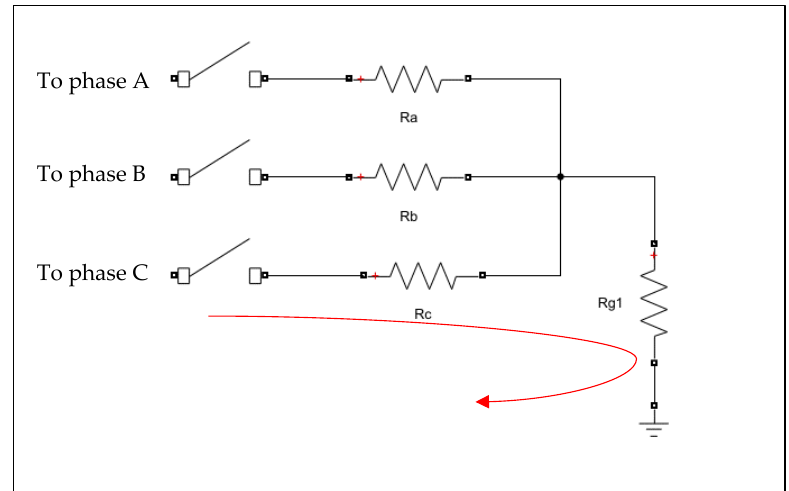
Figure 4. Fault impedance model of insulator failure.